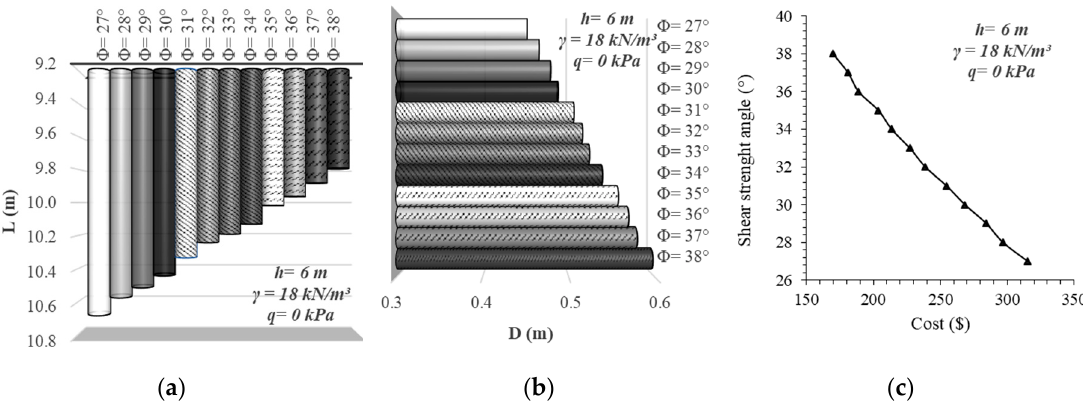
Figure 4. The effects of the change of shear strength angle to the diameter of the cantilever soldier pile ( a ), the length ( b ), and the unit cost of pile ( c ) (for h = 6 m excavation depth).